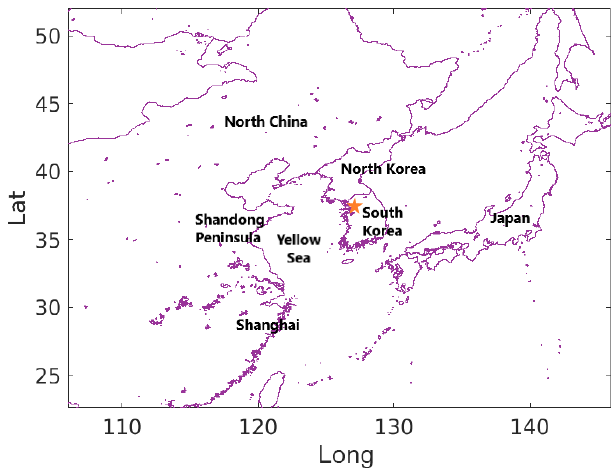
Figure 3. Domain of the study; the orange star indicates the Seoul Metropolitan Area